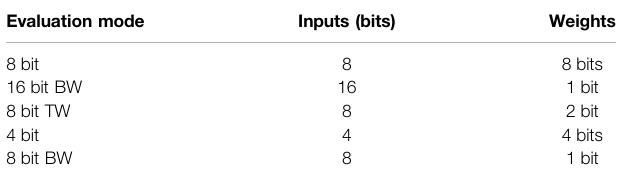
TABLE 3 | Evaluation modes description of Neural